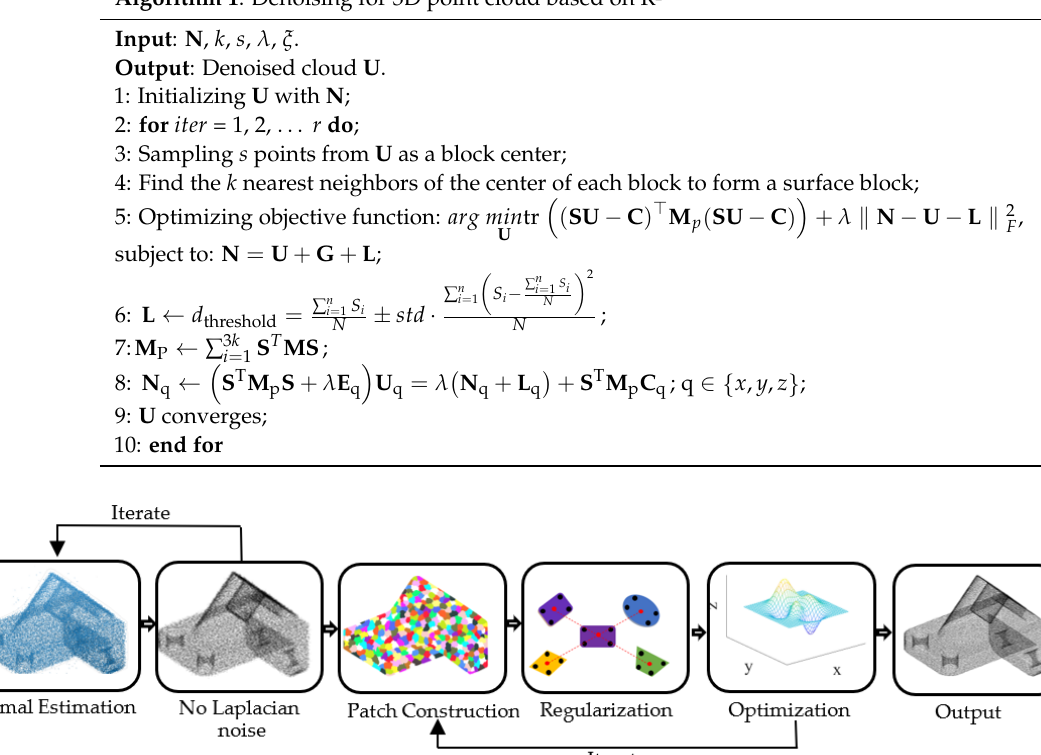
Algorithm 1 : Denoising for 3D point cloud based on R-